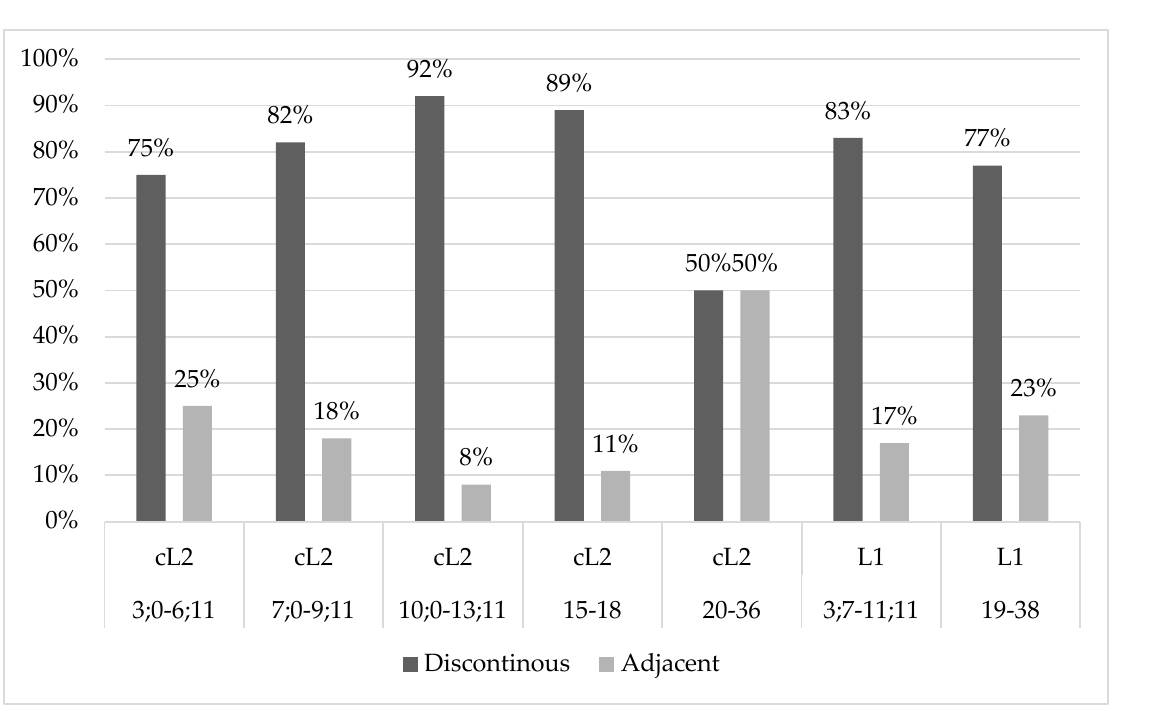
Figure 6. Relative frequency of discontinuous vs. adjacent word order pattern in verb phrases with pronouns in early sequential bilinguals (cL2) and monolinguals (L1).